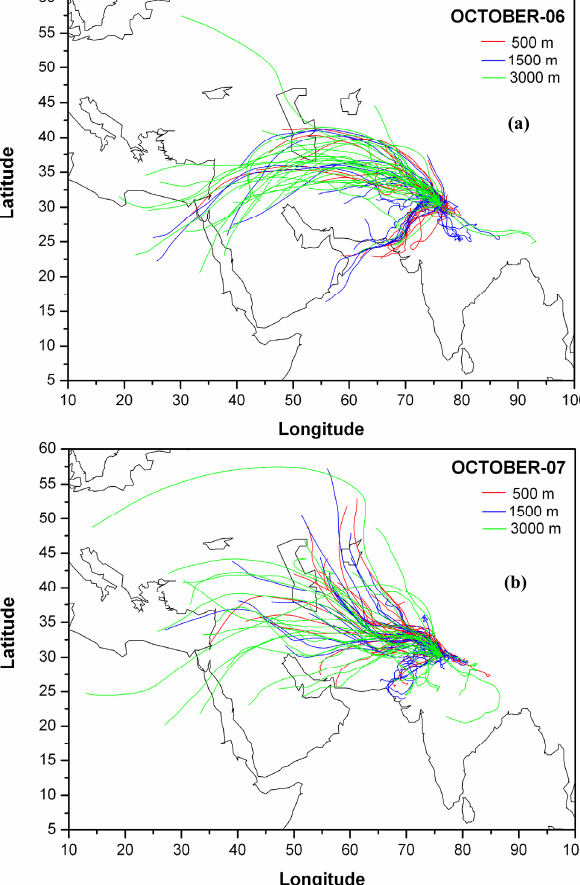
Fig. 2. NOAA-HYSPLIT five-day wind back trajectories ending at Patiala during 6 October and 7 October at 500 (red), 1500 (blue) and 4000m (green).